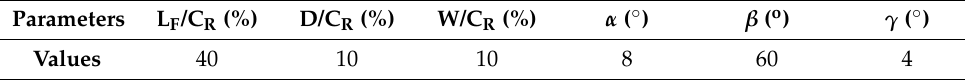
Table 1. Reference values for INOS.